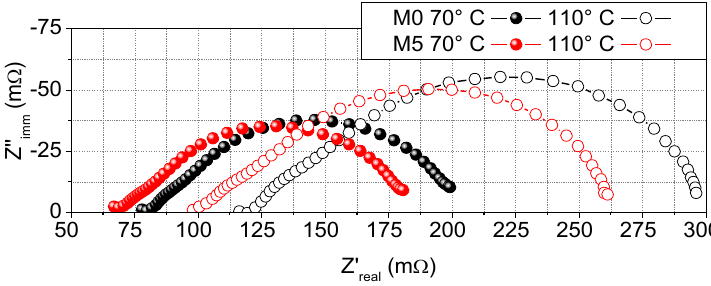
Figure 11. Electrochemical impedance spectroscopy (EIS) reported as Nyquist plots recorded in the range 10 kHz–1Hz at different temperature at 30% RH for cells containing the M0 and M5